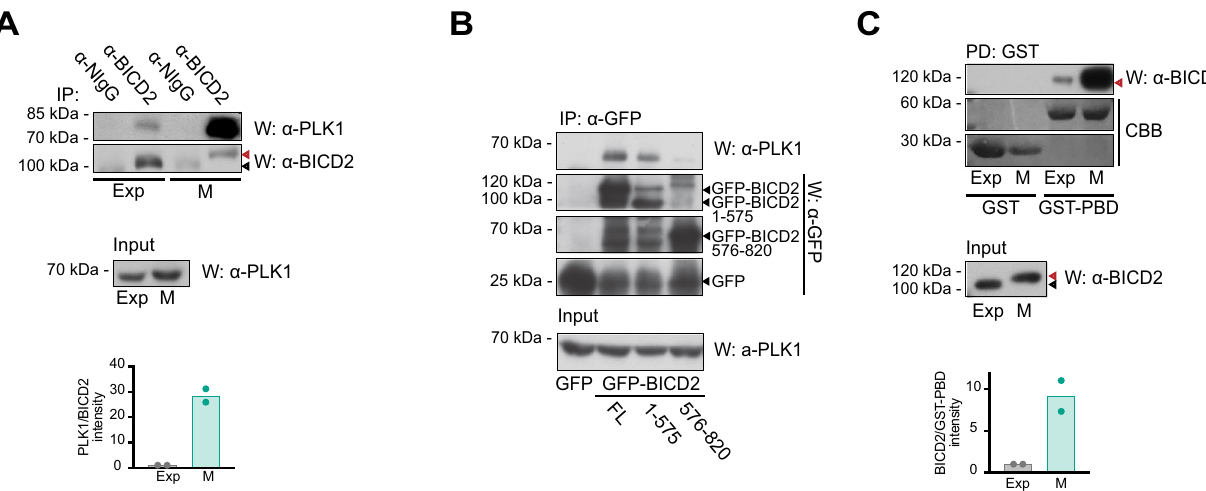
Fig. 1 | BICD2 interacts with PLK1 through its Polo-Box Domain. A Coimmunoprecipitation of endogenous PLK1 and BICD2 in exponentially grow- ing ( Exp ) and mitotic ( M ) HeLa cell extracts. anti-BICD2 or normal IgG ( NIgG ) immunoprecipitates ( IP ) were analyzed by western blot ( W ) using either anti-PLK1 or anti-BICD2 antibodies. Note BICD2 high apparent molecular weight in mitotic cells, red arrowheads. PLK1 in the corresponding extracts is shown in the lower panel.Themeanofquanti fi cationscorrespondingtotwoindependentexperiments is shown (PLK1 intensity/BICD2 intensity in the immunoprecipitates; this and sub- sequent experiments source data are provided in the Source Data fi le). B PLK1 interactswiththeN-terminalregionofBICD2.Immunoprecipitatesoftheindicated recombinant GFP-fusion proteins were analyzed by western blot using either anti- PLK1, to detect the endogenous kinase, or anti-GFP. PLK1 in the corresponding extractsisshowninthelowerpanel.NotethatdifferentfragmentsofGFP-BICD2are produced when recombinant proteins are expressed in cells. Arrowheads